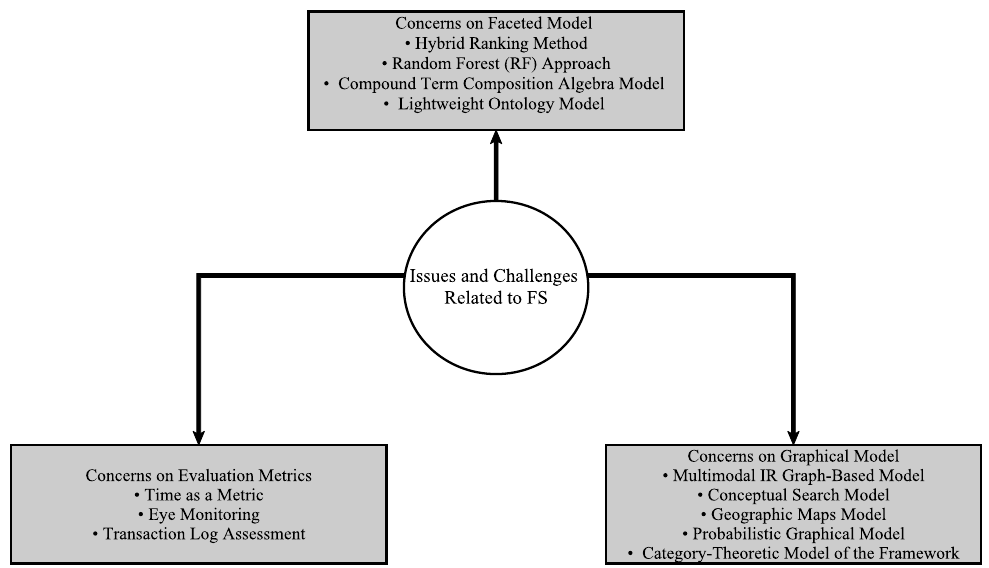
Figure 10. Categories of challenges for faceted search based on information